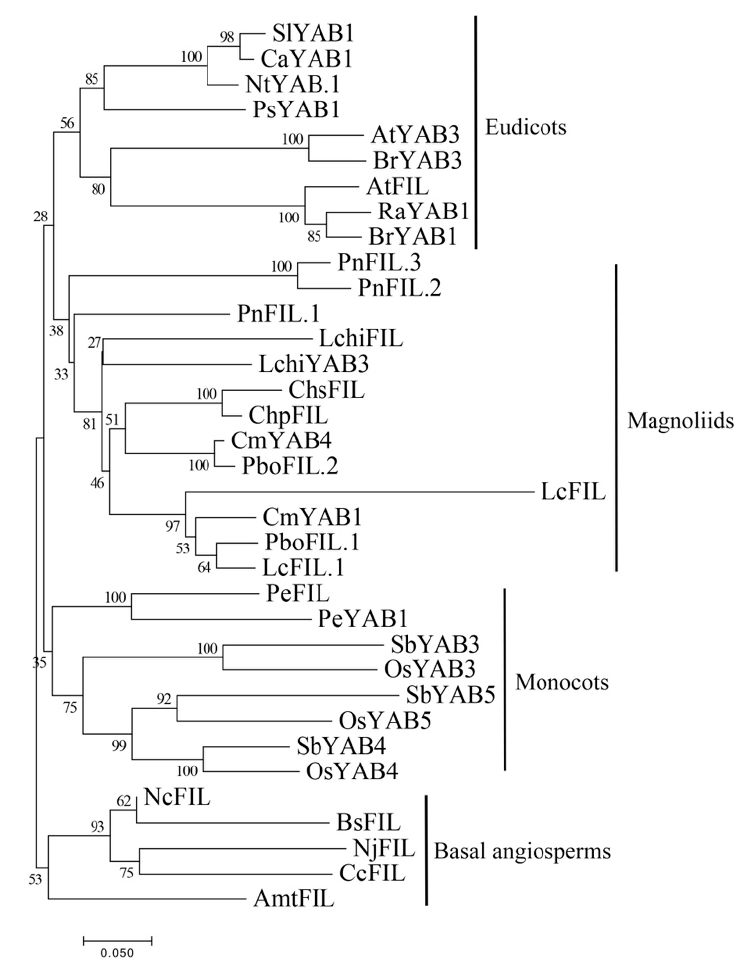
Figure 7. Phylogenetic tree of FIL proteins from the angiosperms. The phylogenetic tree was constructed with the NJ method using MEGA 7.0 software. Bootstrap analysis was conducted with 1000 replications. The same acronym represents the same species: Cm: C. micranthum ; Chp: C. praecox ; Lc: L. cubeba ; Chs: C. salicifolius; Pbo: P. bournei ; Pn: P. nigrum ; Lchi: L. chinense . The protein accession list for related proteins is collected in Table S1.